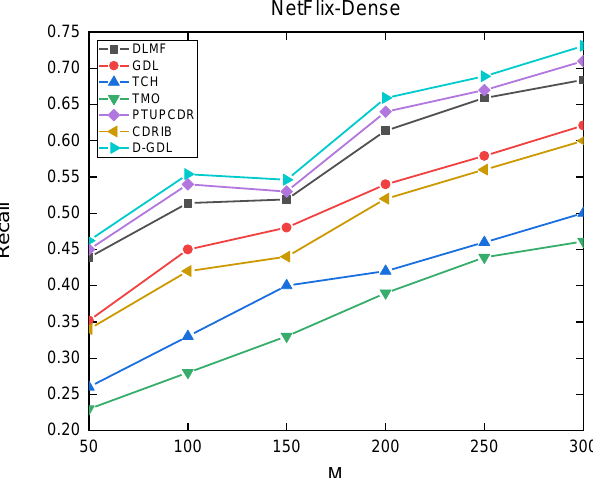
Figure A7. Performance of D-GDL against the comparative approaches based on Recall vs. M for Netflix dataset in the dense setting.